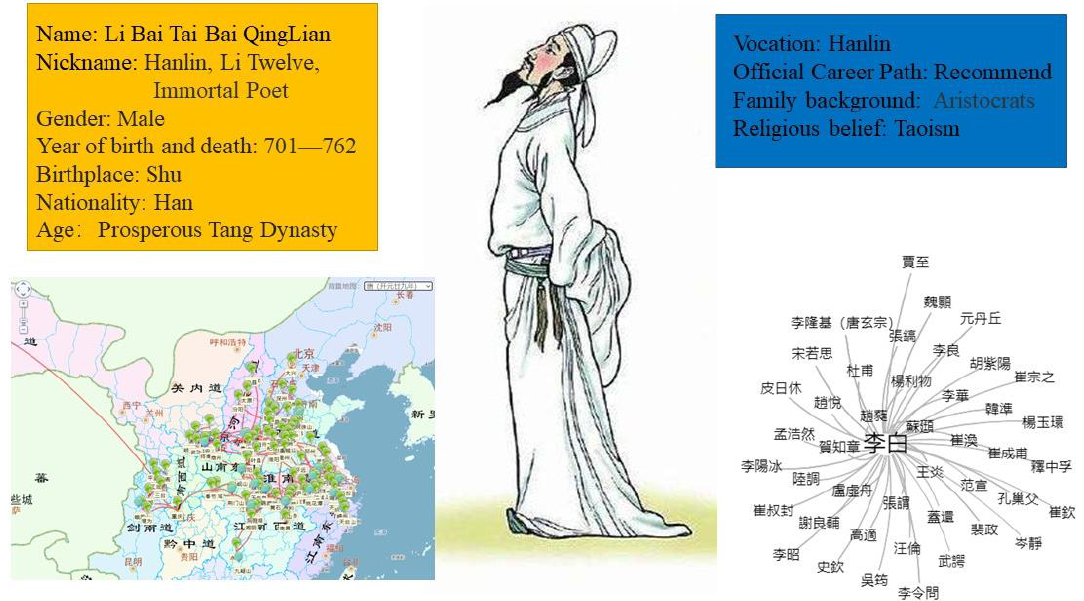
Figure 7. Li Bai profiling for authorship attribution. The bottom-left part represents the location map of Li Bai and the bottom-right part represents the citation relationship with Li Bai.